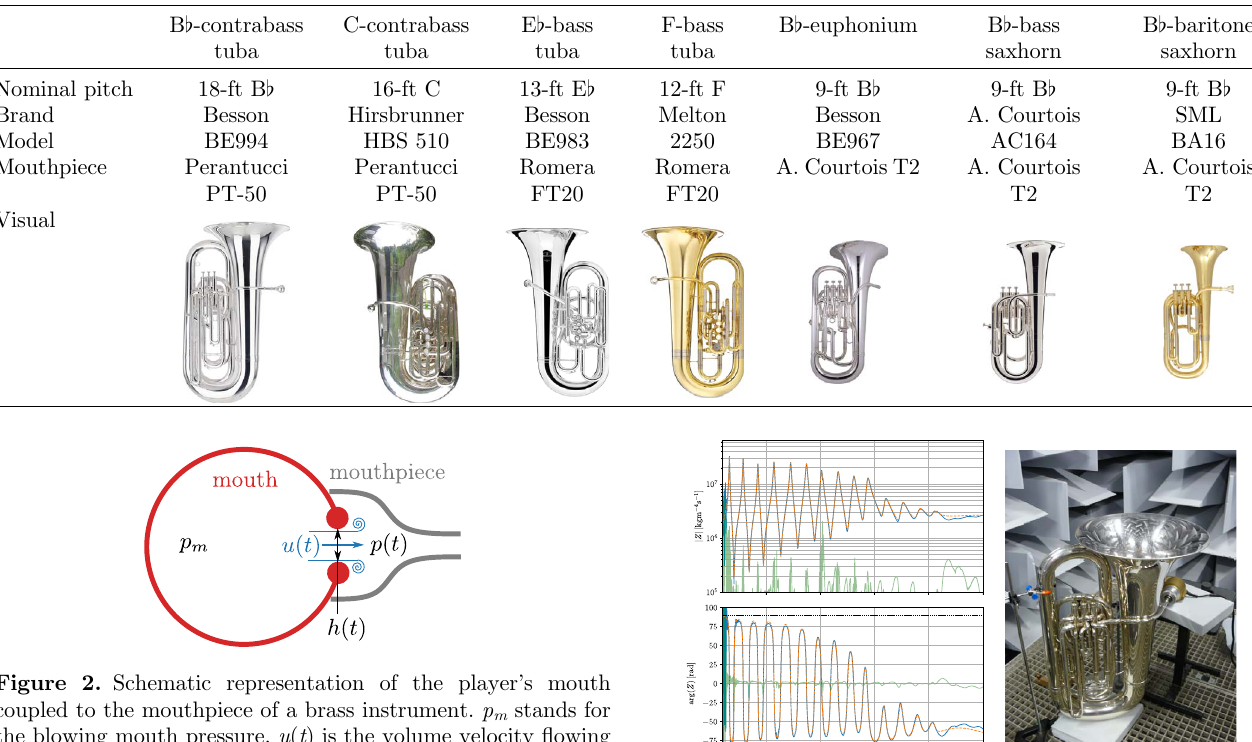
, related to the frequency F nom of its nominal nom